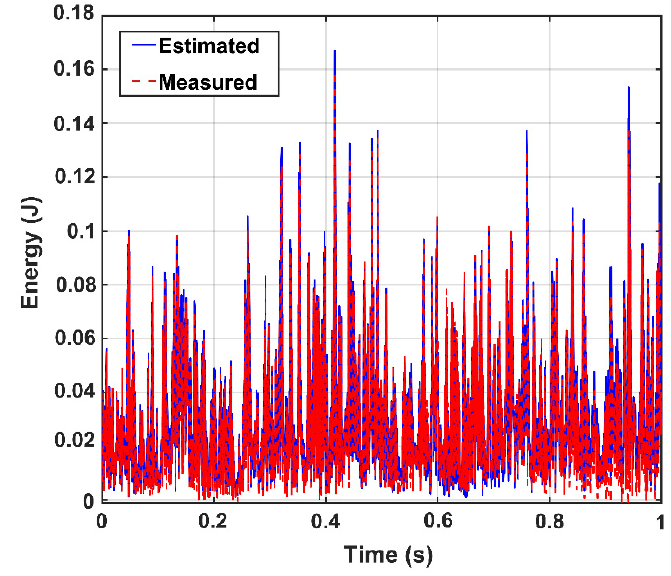
Figure 8. Comparison of the IMFs’ energy of sensor-10 between the outputs of the trained model (i.e., estimated) and the measured data for 100% damage state of the truss.